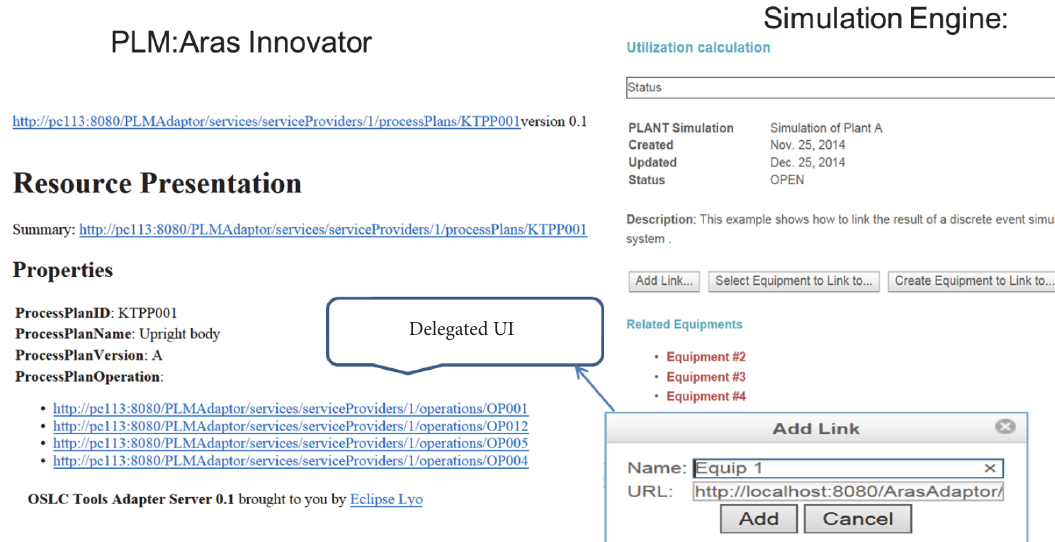
Figure 16: Delegated User Interface of Innovator to SimJava.